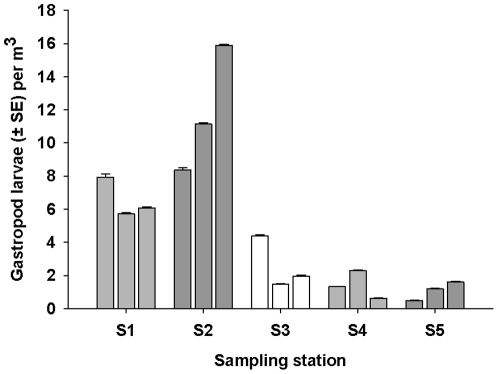
Mean number of Austrolittorina cincta settlers (± SE) per settlement panel (n = 8) found on artificial islands (n = 2) at different distances from Kapiti Island (S1–S5) identified using a microsatellite markers.S1 = 1 km S, S2 = 0.5 km N, S3 = 5 km N, S4 = 15 km N, S5 = 50 km N.